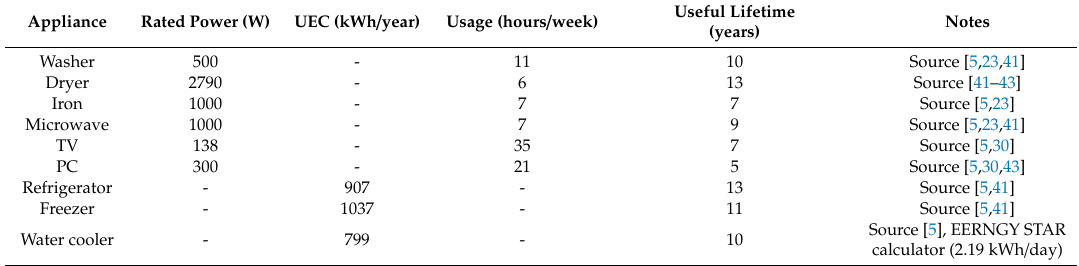
Table 3. List of household appliance metrics that include corresponding power requirements, average run-time, and useful